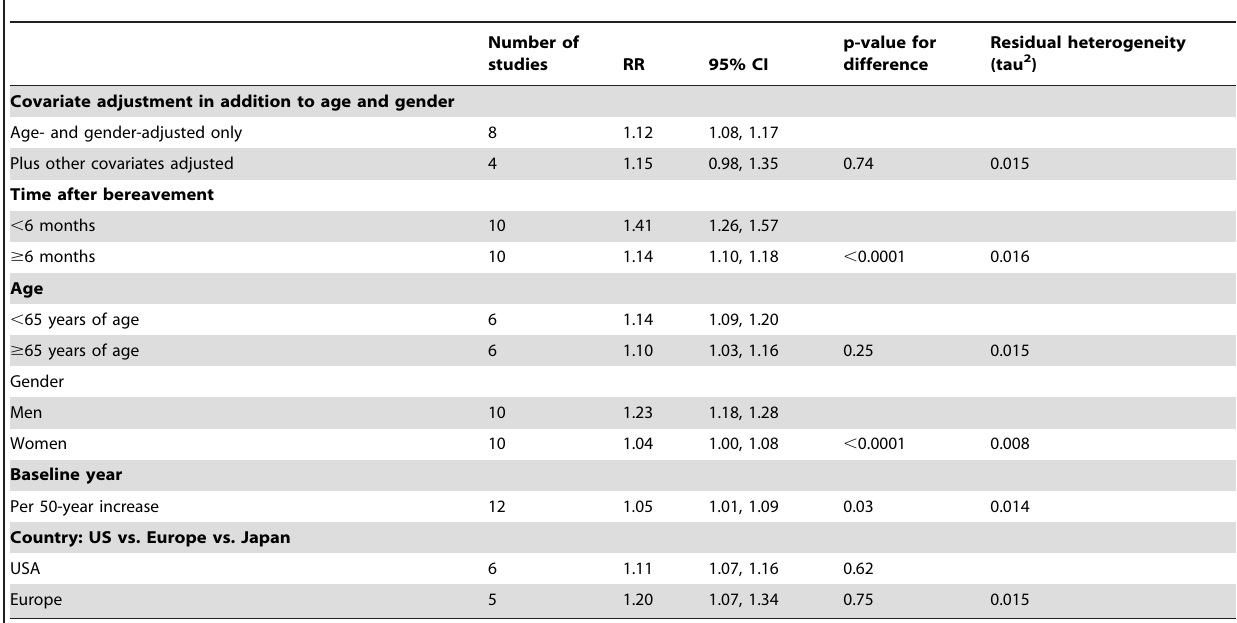
Table 2. Result of the Meta-Regression: Test of Interaction Effect between the Widowhood and Various Study Characteristics.